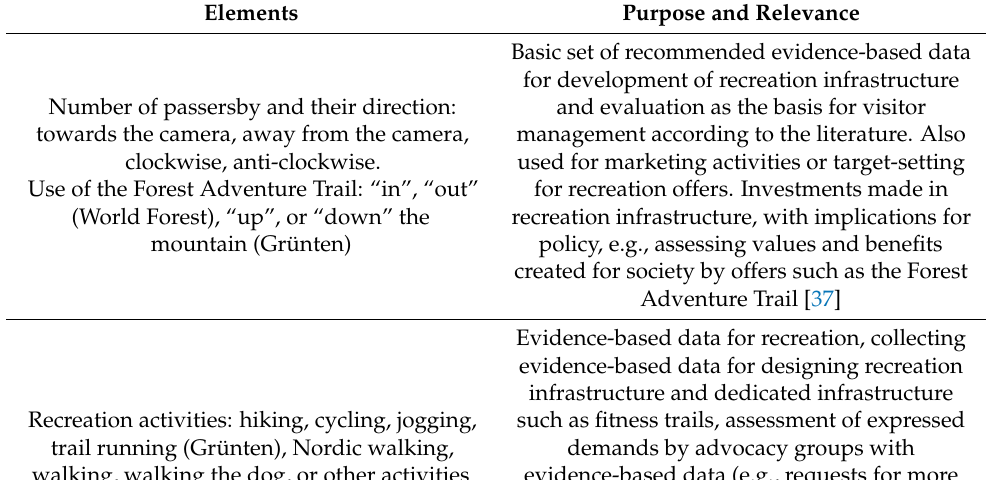
Table 1. Elements selected for monitoring and collecting